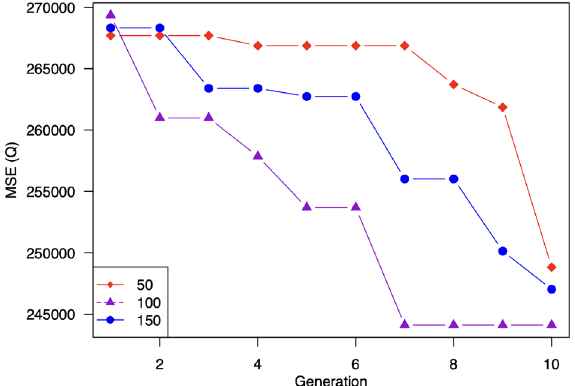
Figure 9. Impacts of number of individuals in population on model performance. MSE tends to decrease when increasing the number of generation. The setting with ten individuals per generation achieves the best performance.